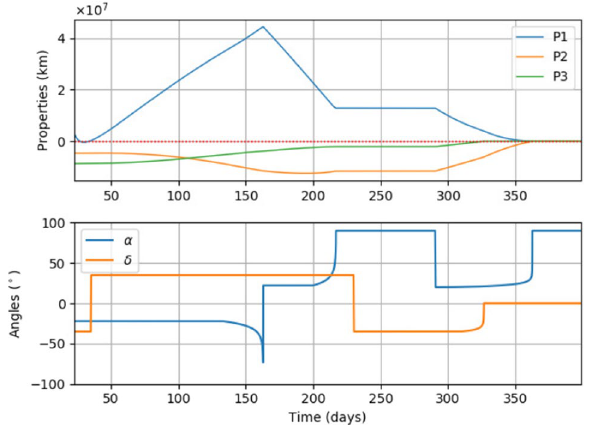
Figure 12. Sail properties for a tof of 398 days and sail loading of 61.2g / m 2 .